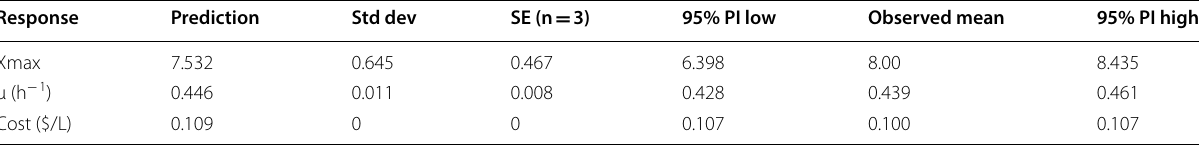
Table 6 Validation of optimal concentration predicted Response